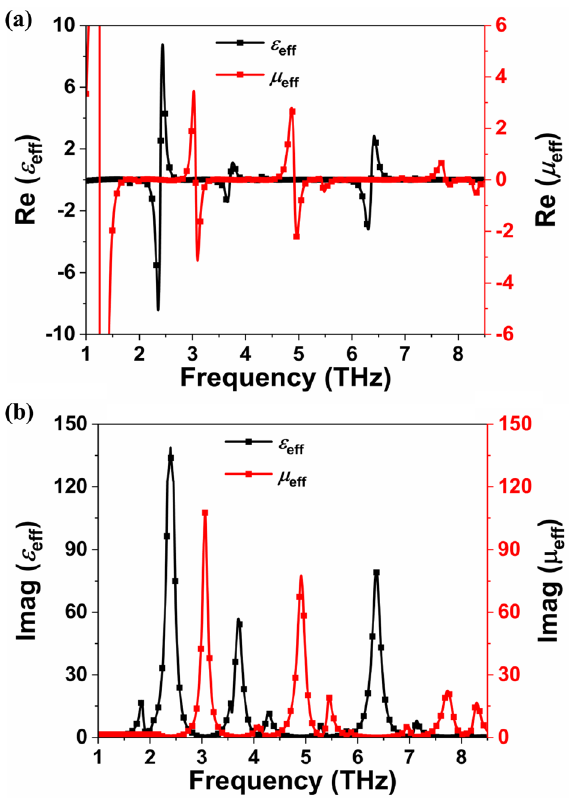
Figure 3. ( a ) Real parts of ε eff and μ eff and ( b ) Imaginary parts of ε eff and μ eff of the proposed absorber.